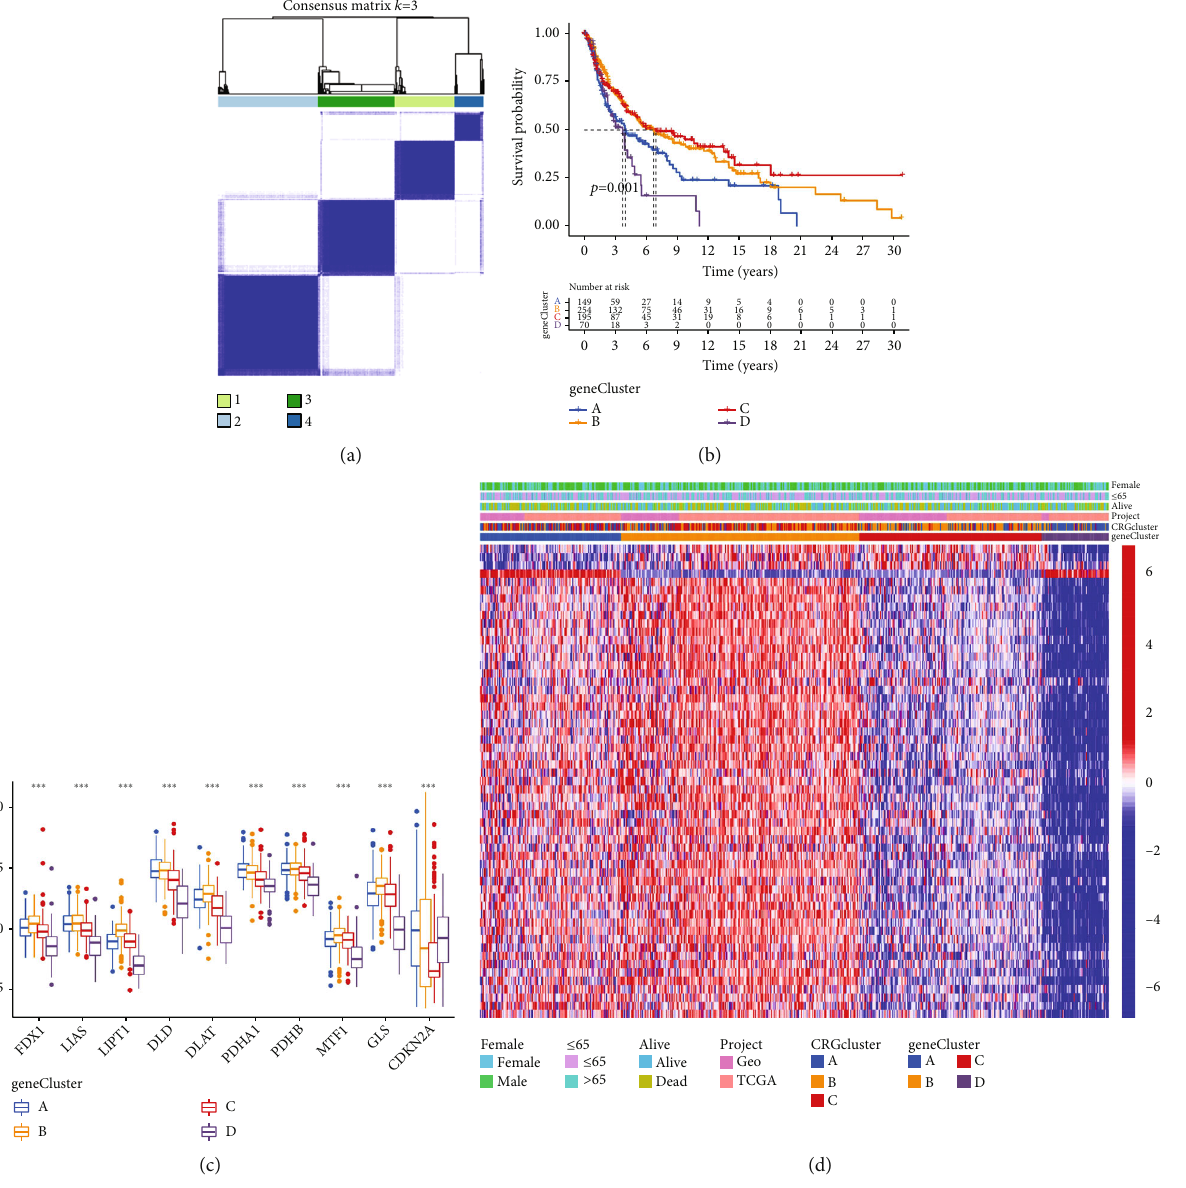
Figure 5: Consensus clustering analysis based on DEGs. (a) DEGs were used for consensus clustering, and the optimal K value was determined to be 4. Patients were divided into four subclusters. (b) K-M survival curves between four DEG subclusters. (c) Cuproptosis gene expression levels in four DEG subclusters. (d) The heat map of DEGs and the various clinical characteristics found in the four DEG subclusters. DEGs: di ff erentially expressed genes; K-M: